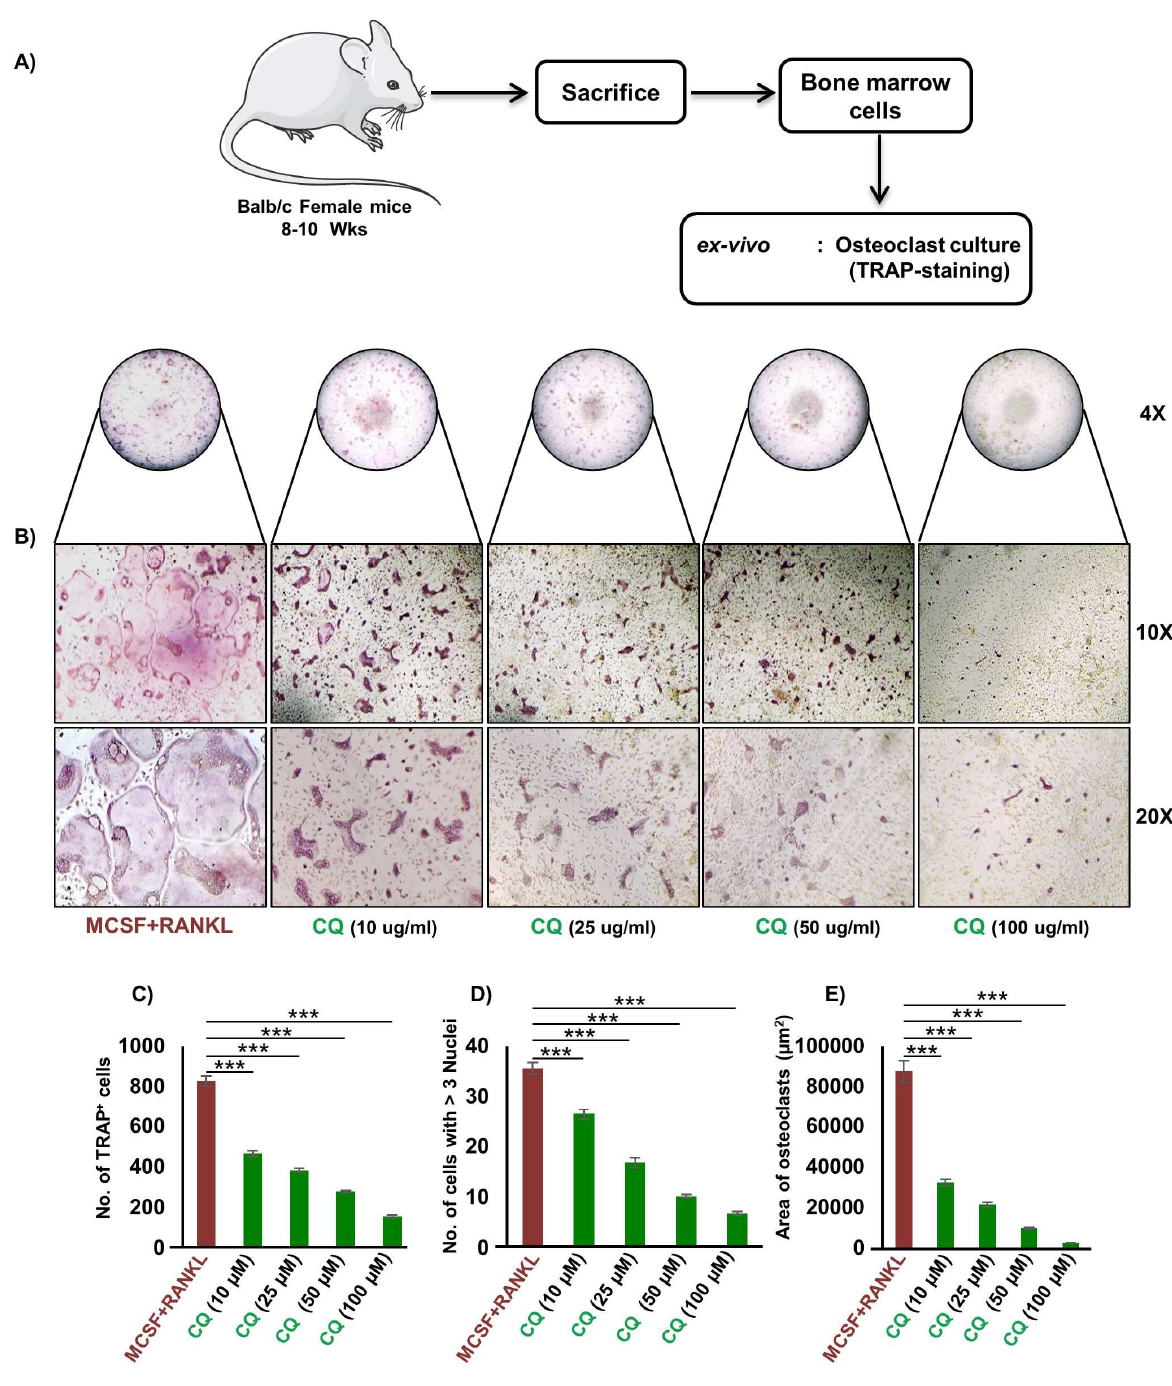
Figure 1. CQ inhibits osteoclastogenesis in a dose-dependent manner: ( A ) Experimental layout followed for ex vivo osteoclast culture from mice bone marrow cells (BMCs). Large multinucleated cells TRAP positive osteoclasts with ≥ 3 nuclei were considered matured osteoclasts. ( B ) Photomicrographs at 4×, 10×, and 20× indicate TRAP staining in osteoclasts. ( C ) Number of TRAP-positive cells. ( D ) Number of TRAP-positive cells with ≥ 3 nuclei. ( E ) Area of osteoclasts. ANOVA was used to analyse the results, and then unpaired Student t-tests were used to compare the indicated groups. Values are expressed as mean ± SEM, and equivalent outcomes were observed in two independent experiments. For the indicated groups, p ≤ 0.05 *** p ≤ 0.001) was used as the cutoff for statistical significance. In the bar graphs, red is indicating the positive control and green is indicating the treatment groups.